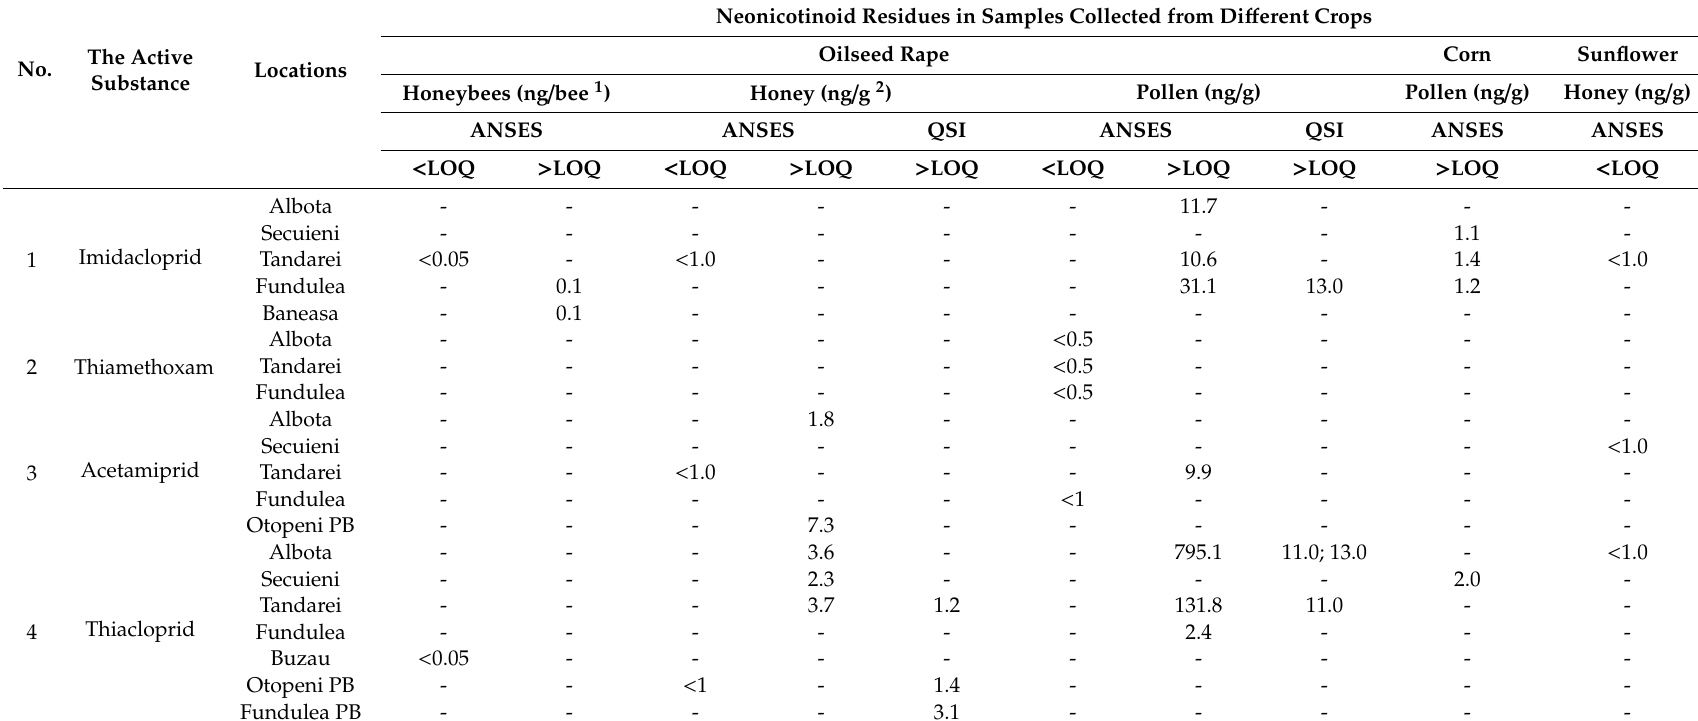
Table 2. The results on the neonicotinoid residues found in samples collected from di ff erent crops and locations in Romania